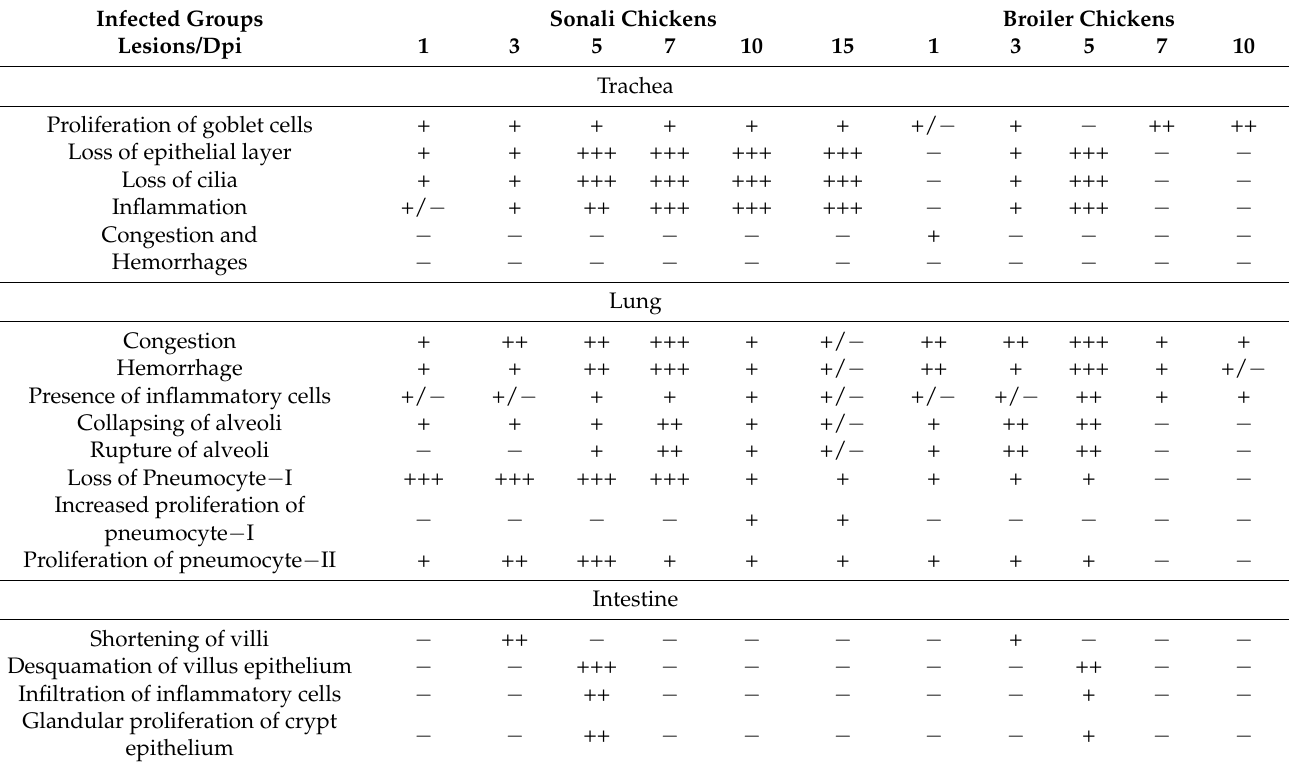
Table 2. Histopathological scoring of different parameters of trachea and lung at experimental infection with LT_2 and LT_56 H9N2 viruses in Sonali and broiler